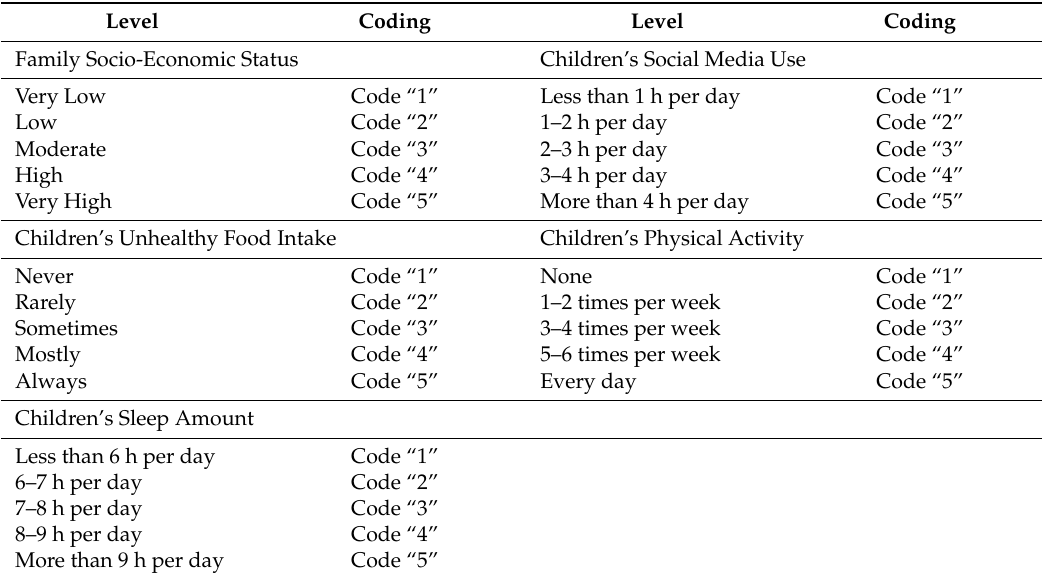
Table 7. Taguchi method